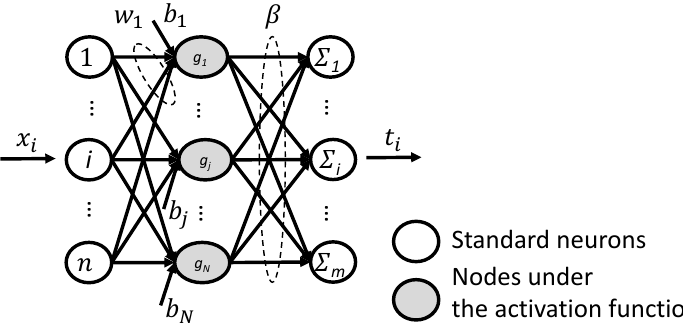
Figure 2. General architecture of a single hidden layer feedforward neural network (SLFN) with the extreme learning machine (ELM)